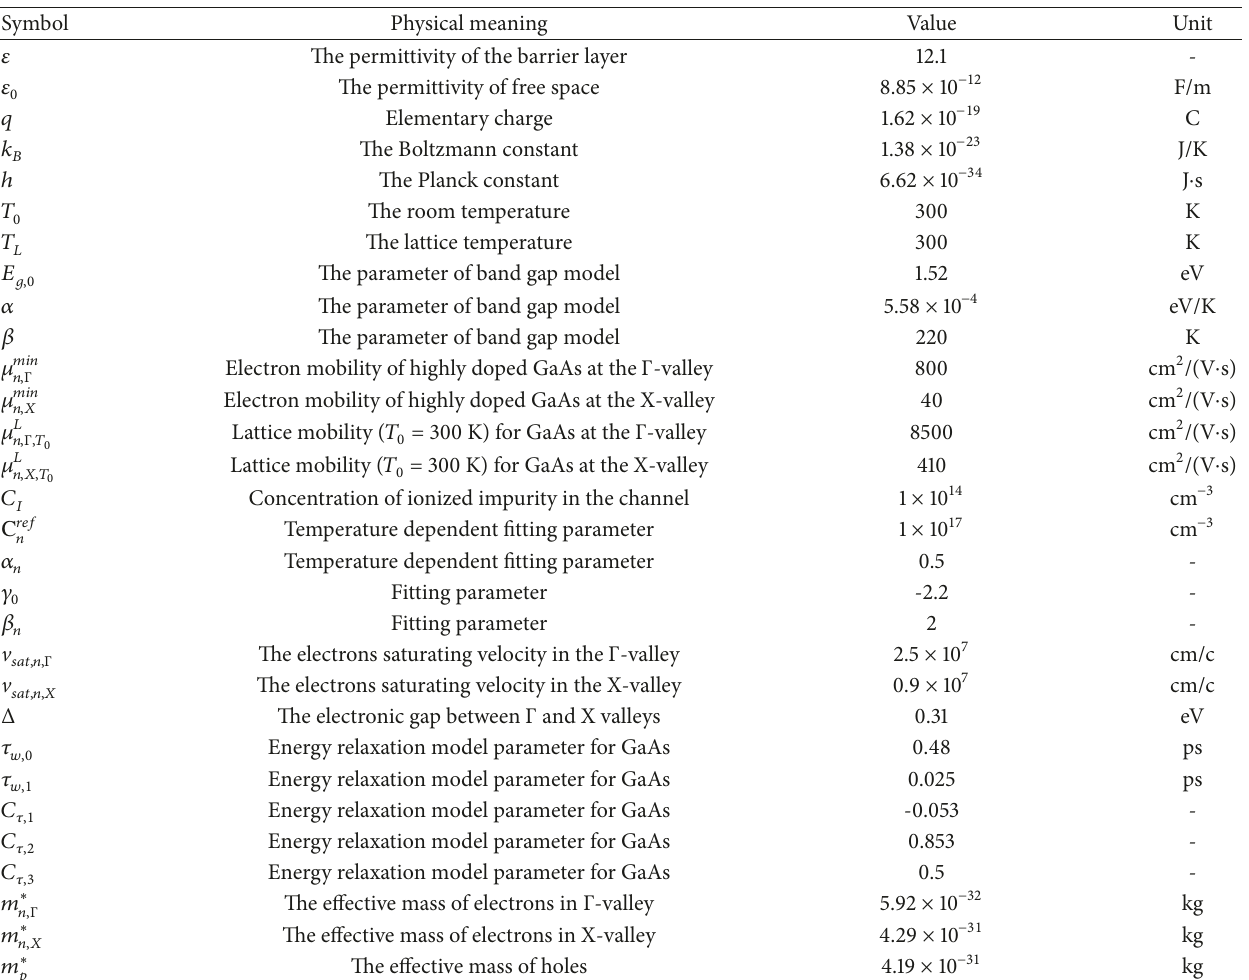
Table 1: List of parameters used in simulation